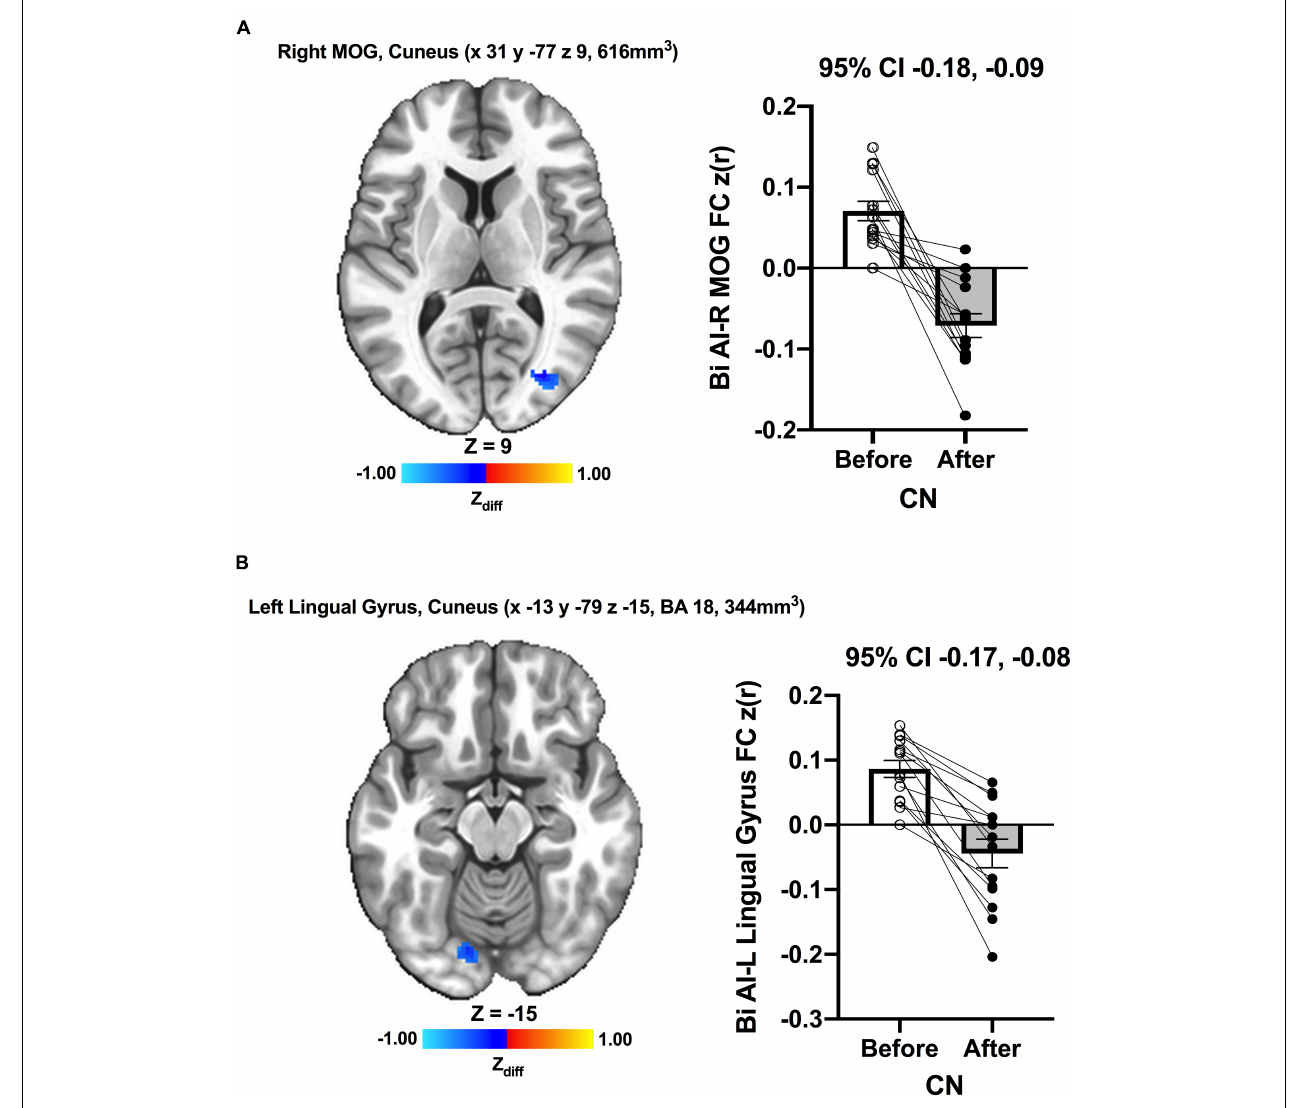
FIGURE 4 | Decreases in functional connectivity between the anterior insula and (A) right middle occipital gyrus and cuneus, and (B) left lingula gyrus and cuneus were found after exercise training in CN individuals. Adjacent bar graphs indicate the connectivity between the anterior insula and respective regions ( ± SEM) for before and after exercise training. 95% CI above bar graphs indicates 95% confidence interval in the difference from before to after exercise